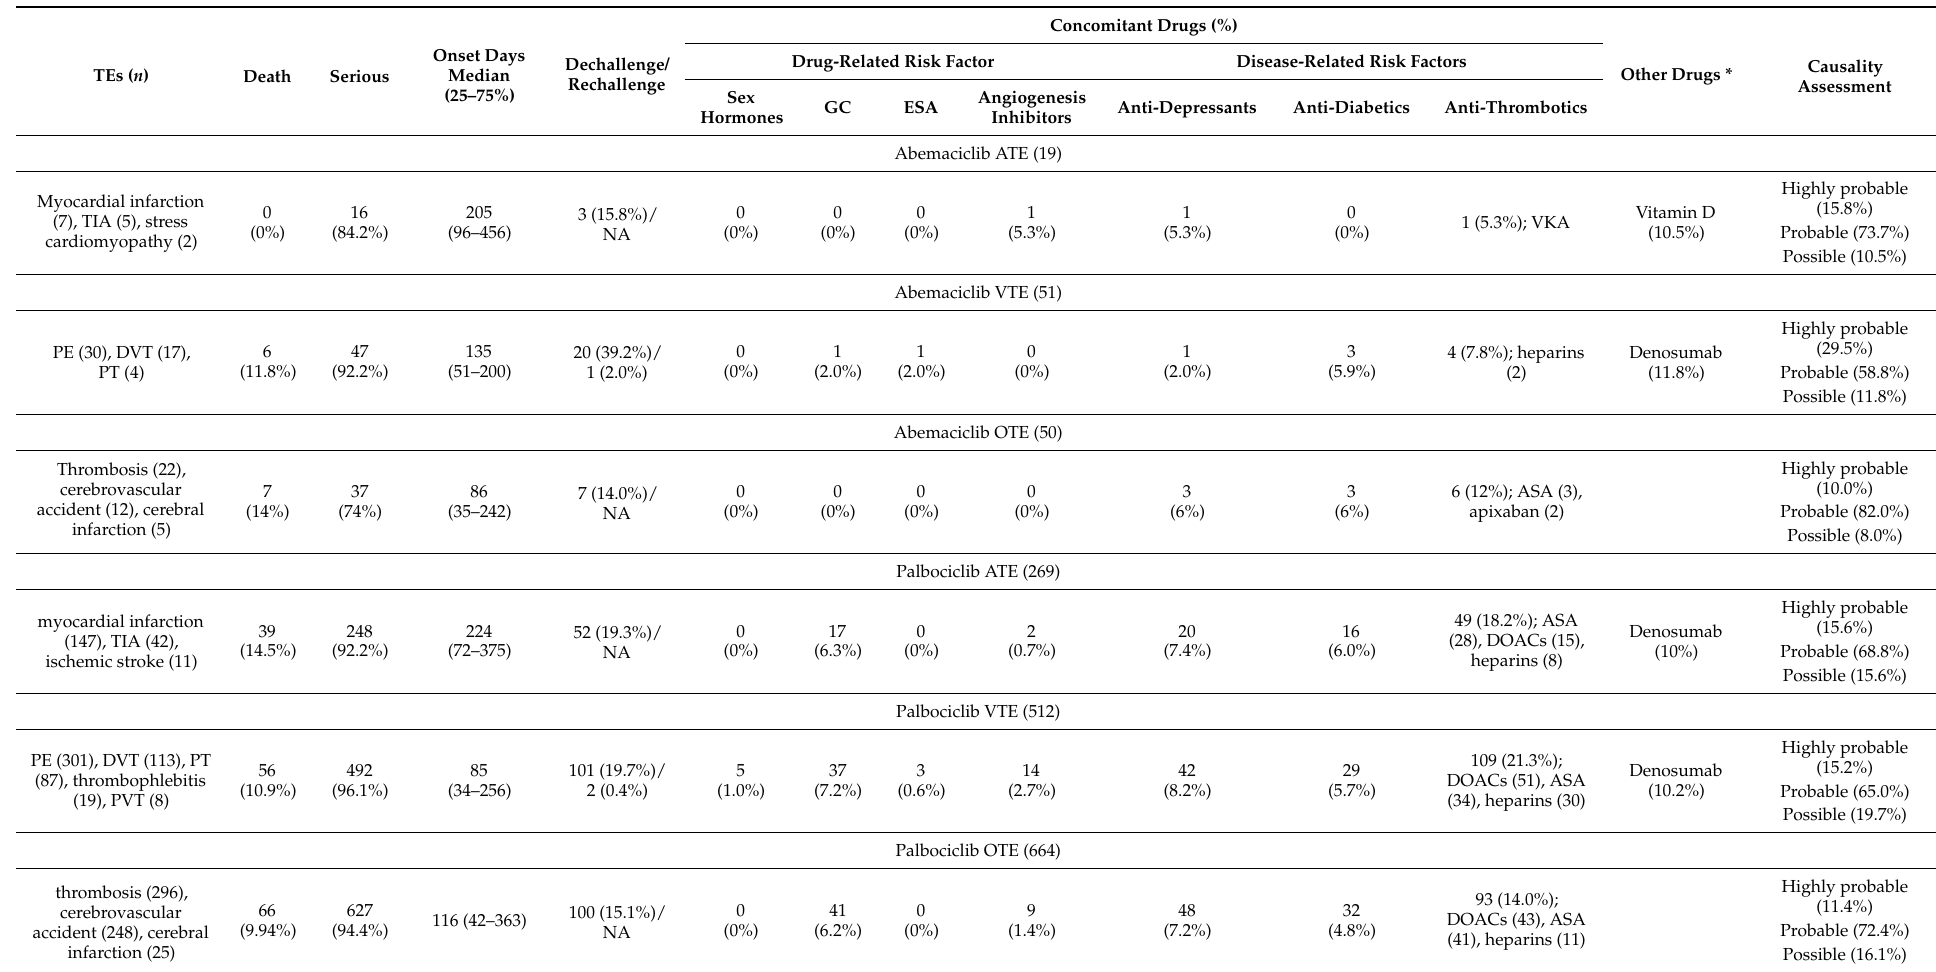
Table 3. Case-by-case